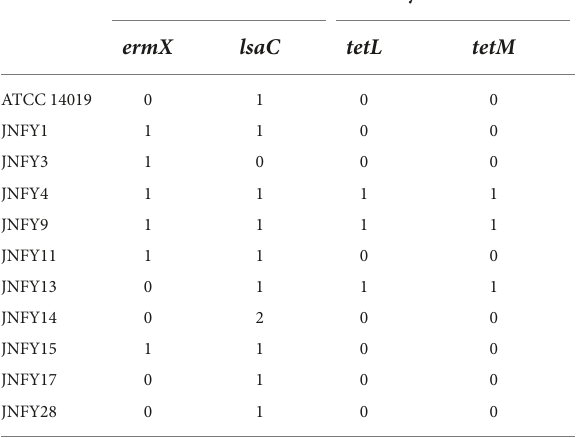
TABLE 3 Antibiotic-resistance genes predicted in genome of the Gardnerella strains.